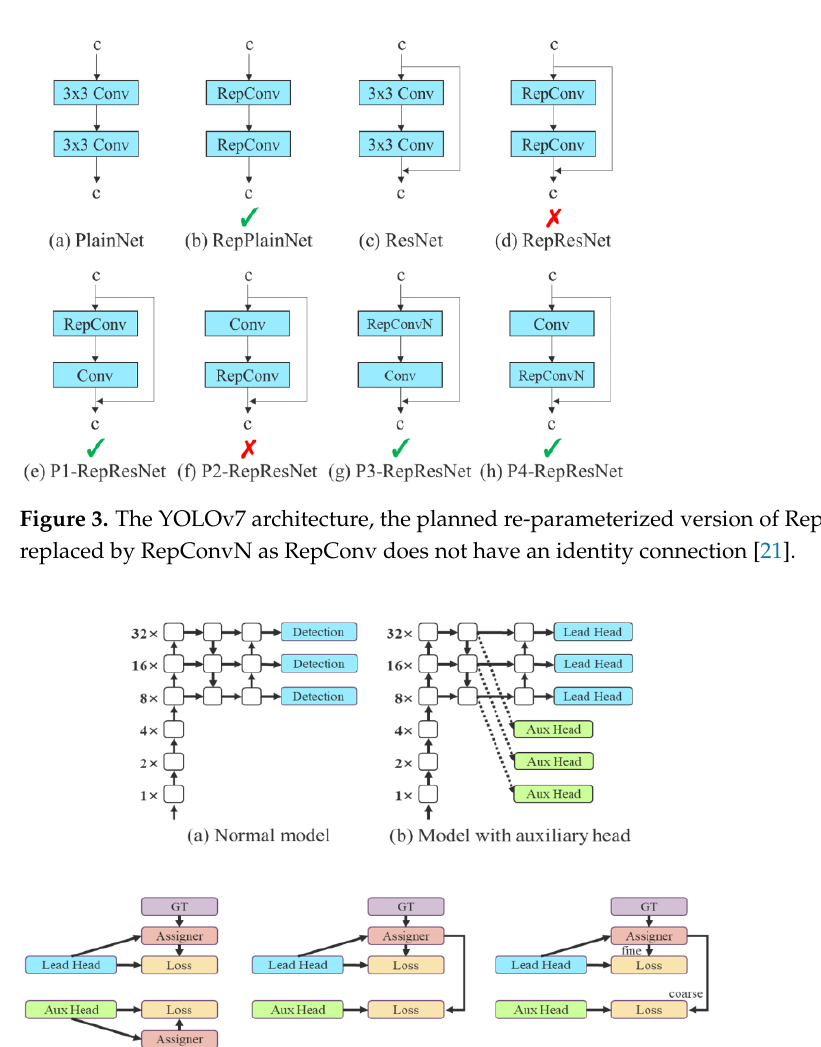
Figure 3. The YOLOv7 architecture, the planned re-parameterized version of RepConv. RepConv is replaced by RepConvN as RepConv does not have an identity connection [21].